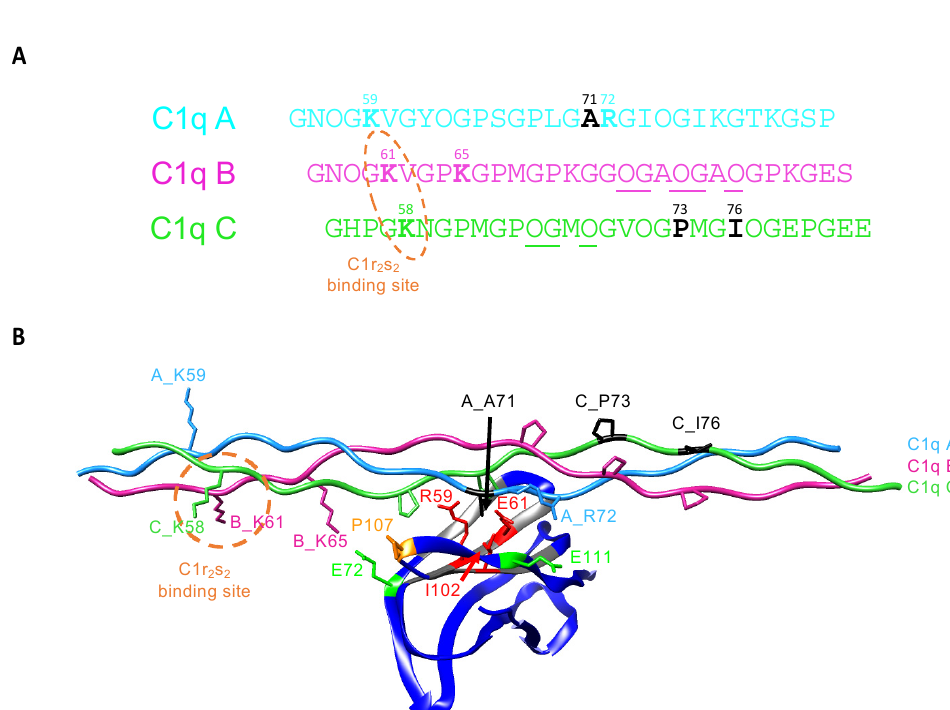
Figure 8. Model of LAIR-1 Ig-like domain in complex with a C1q collagen stem. ( A ) Sequences of C1q A, B and C chains corresponding to the C1q collagen-like region shown in B. The three lysine residues constituting the C1r 2 s 2 binding site (A_K59, B_K61 and C_K58) are in bold and the two essential lysines are surrounded with a dashed orange ellipse. The putative LAIR-1 binding OGXO motifs in this region are underlined. The remarkable residues are labeled with their position numbers. The three residues facing the LAIR-1 I102 in each alternative model are labeled in black. The “O” in the sequences stands for proline residues modified into hydroxyprolines, as determined in the literature [27,28]. ( B ) Model of LAIR-1 Ig-like domain (blue, PDB code: 3KGR) in interaction with the C1q CLR triple helix (A chain in cyan, B chain in pink and C chain in green). The collagen-binding groove of LAIR-1 is shown in grey and the side chains of the identified key binding residues are shown and labeled. Mutated lysine 65 and arginine 72 of C1q B and A chains, respectively, are labeled. The residues facing LAIR-1 I102 in each model are colored in black. The side chains of the identified OGXO motifs are shown in lines.